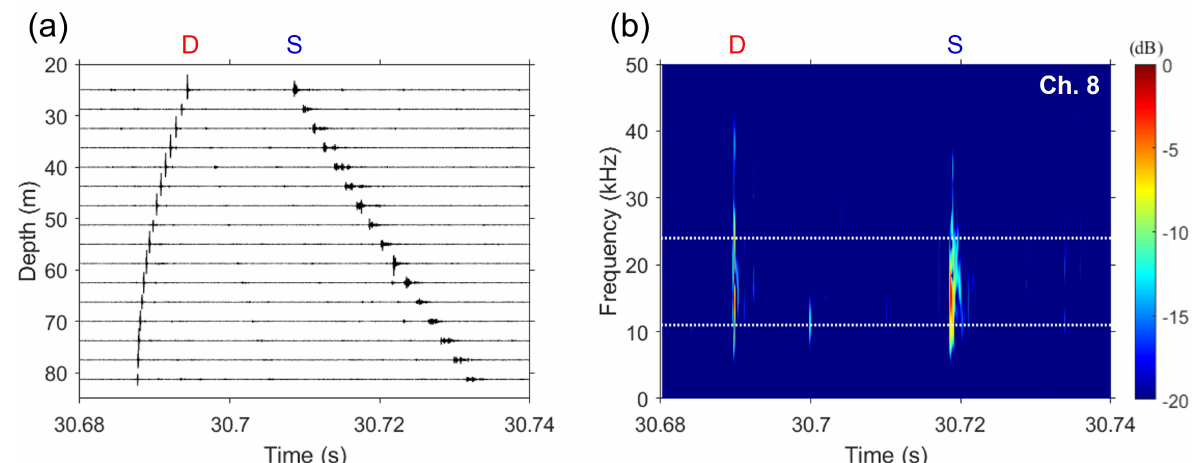
Figure 6. (a) Cracking sounds recorded by the VLA on JD 141 (JD141 06:55:30). D and S denote the direct and surface-reflected paths, respectively, separated at around 30.7 s. (b) Spectrogram of cracking sounds received on a single element of the VLA at a depth of 51.25 m (eighth channel). The dominant frequency band within the white dotted lines (11–24 kHz) is selected to estimate the DOAs.